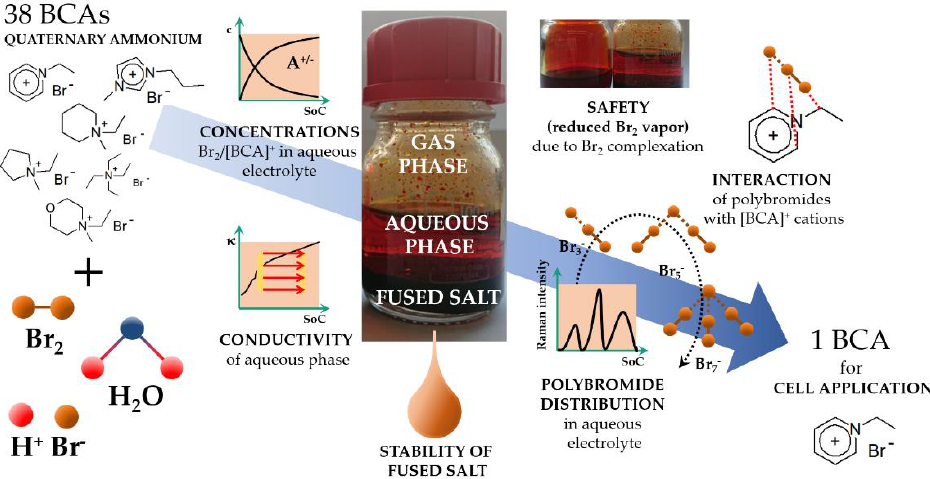
Figure 1. Scheme of the selection procedure of BCAs from 38 different compounds derived from six building blocks in an aqueous HBr/Br 2 electrolyte. The selecting process includes the properties of primarily the aqueous electrolyte phase, such as safety, performance, stability, bromine sequestration and electrolytic conductivities. The results are used to draw conclusions about the interaction of the [BCA] + cations with the polybromides Br 2n+1 − , which are used to explain the phenomena. On the basis of these results, one BCA out of 38 BCAs was selected for later investigations in the cell.